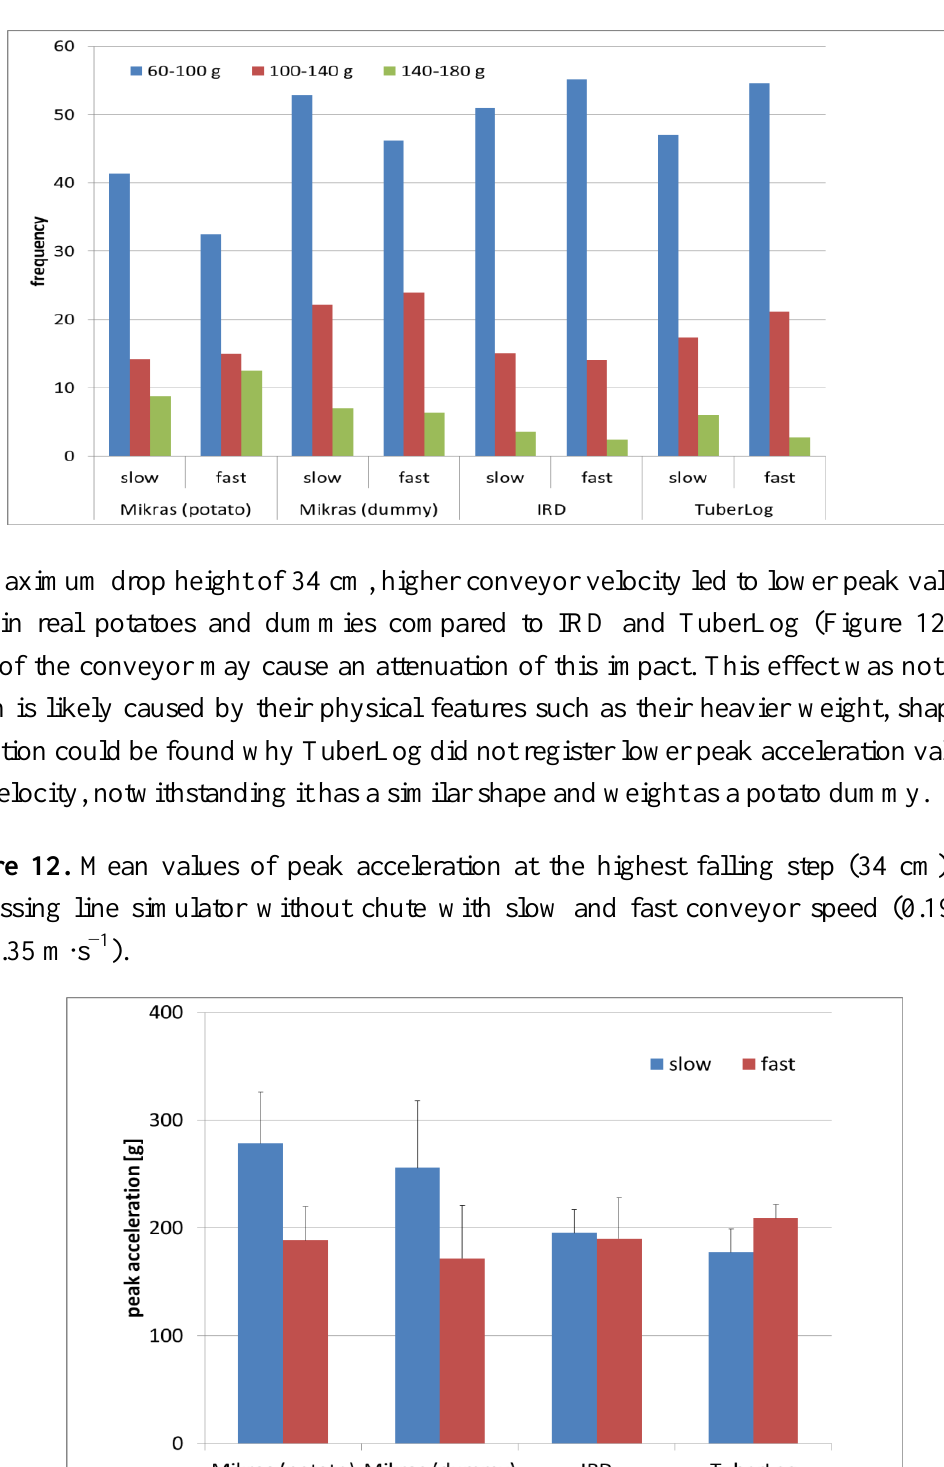
Figure 11. Frequency of impacts with peak acceleration between 60 and 180 g measured with different electronic fruits during 10 runs through the processing line simulator without chute with slow and fast conveyor speed (0.19 m·s −1 and 0.35 m·s −1 ).